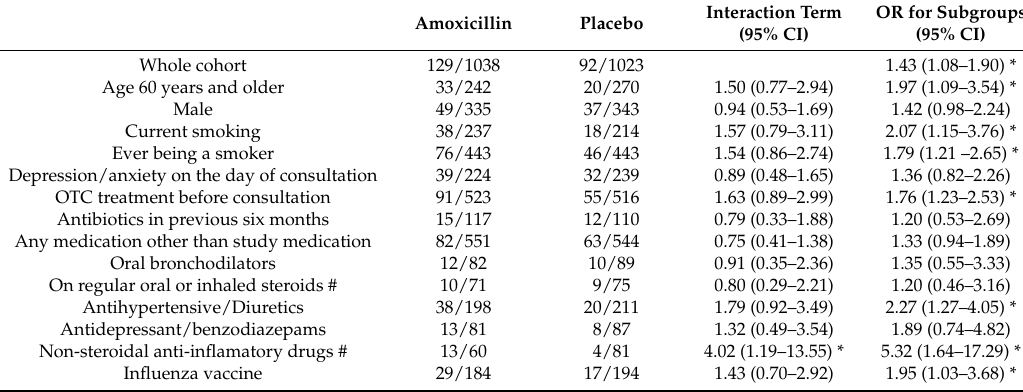
Table 2. Diarrhoea in the whole cohort and in subgroups of adult patients in the first week after presenting to primary care with a LRTI and allocation to amoxicillin or